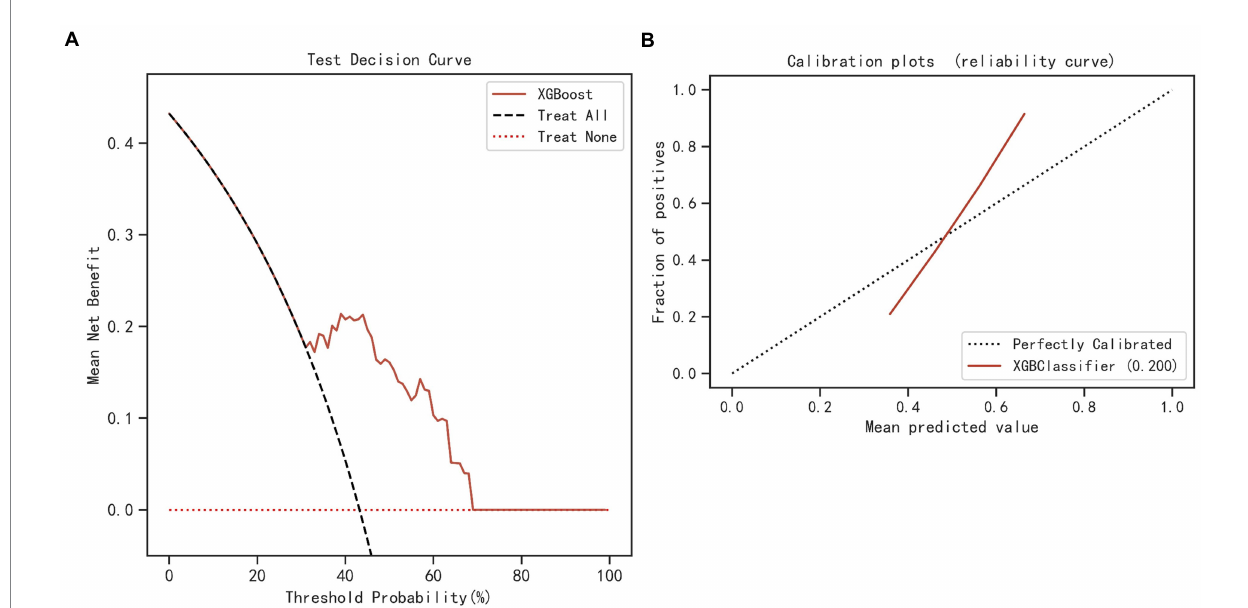
FIGURE 3 Comparing the different ML models’ AUC in the training (A) and validation (B) sets. ML, machine learning; AUC, area under the receiver operating characteristic curve; XGBoost, eXtreme Gradient Boosting; GNB, Gaussian Naïve Bayes; CNB, Complement Naive Bayes; MLP, multi-layer perceptron neural network; SVM, support vector machine.